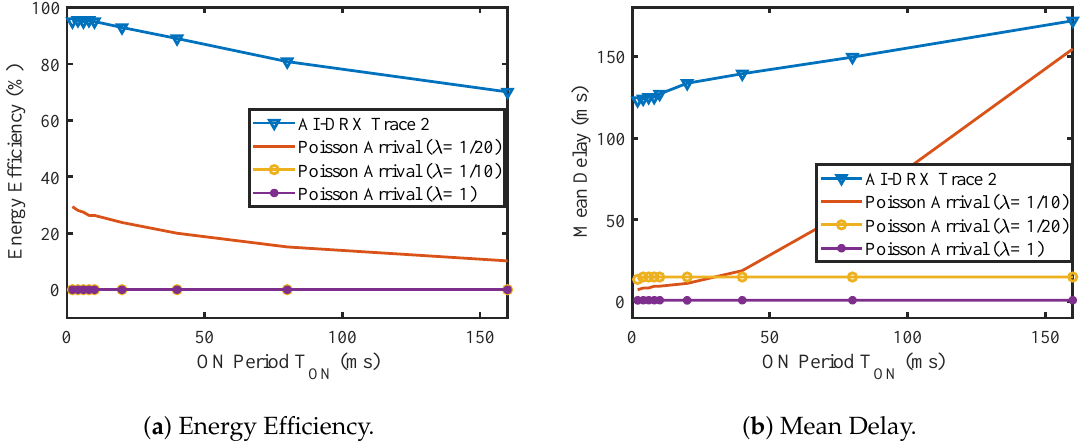
Figure 13. AI-DRX energy efficiency and mean delay comparison with Poisson Arrival with varying T ON ( Th Min = 300, Th Max =